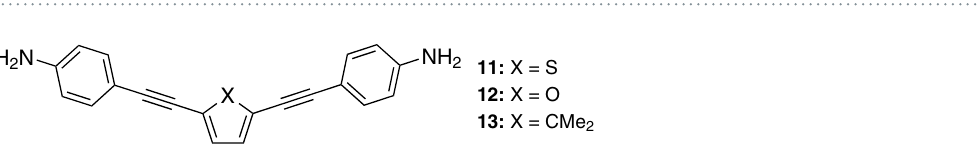
Figure 1. Structures of the molecules discussed in this work and their nomenclature. The structures represent the para -linked series 1–5 (top) and meta -linked series 6–10 (bottom).